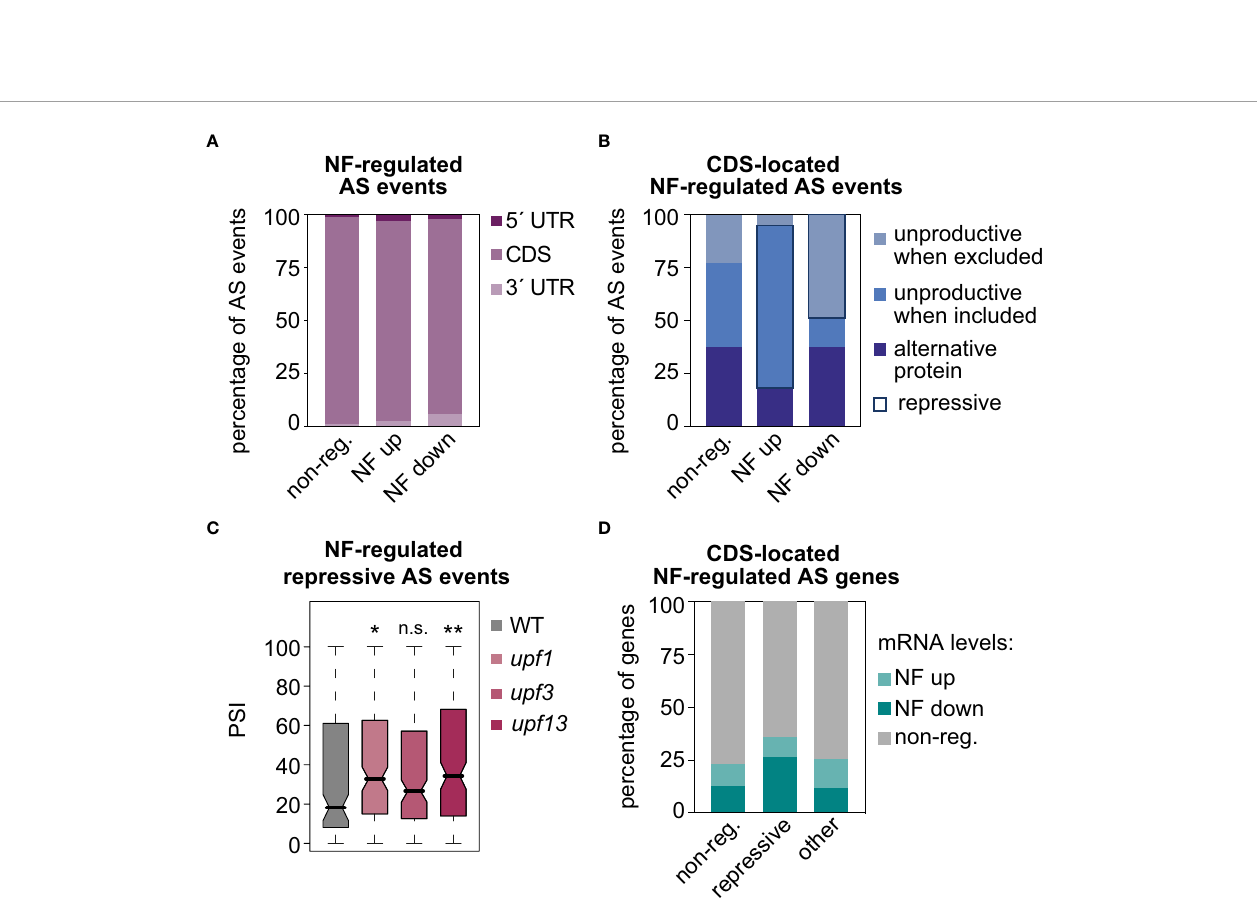
FIGURE 4 Molecular impact of AS events regulated by retrograde signals. Percentage of AS events located in untranslated (UTRs) or gene coding (CDS) regions (A) and percentage of CDS-located AS events that potentially produce unproductive mRNAs or alternative protein isoforms (see Material and Methods for details) (B) , in three different groups of AS events: non-regulated (non-reg.), up- or downregulated by nor fl urazon (NF). Repressive AS events are highlighted. (C) Boxplot representation of the percent of inclusion (PSI) values of the NF-regulated repressive AS events in wild-type (WT), upf1 , upf3 and upf1upf3 seedling samples. Asterisks indicate statistically signi fi cant differences in respect of the WT (Mann-Whitney U test; *, P < 0.05; **, P < 0.01; n. s., non-signi fi cant). (D) Percentage of genes regulated or not by splicing, harboring repressive AS events or other types of CDS-located AS events (other), that belong to our set of differently expressed genes in response to nor fl urazon (see Material and Methods for details in the gene expression